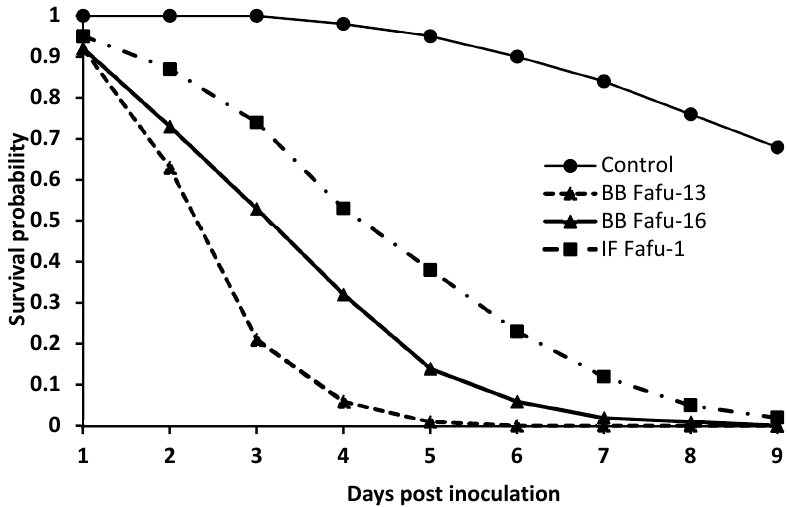
Figure 1. Graph showing survival curves of Asian citrus psyllid adults exposed to Beauveria bassiana BB Fafu-13, BB Fafu-16, Isaria fumosorosea IF Fafu-1 and the control at different days post-exposure (1–9 days).